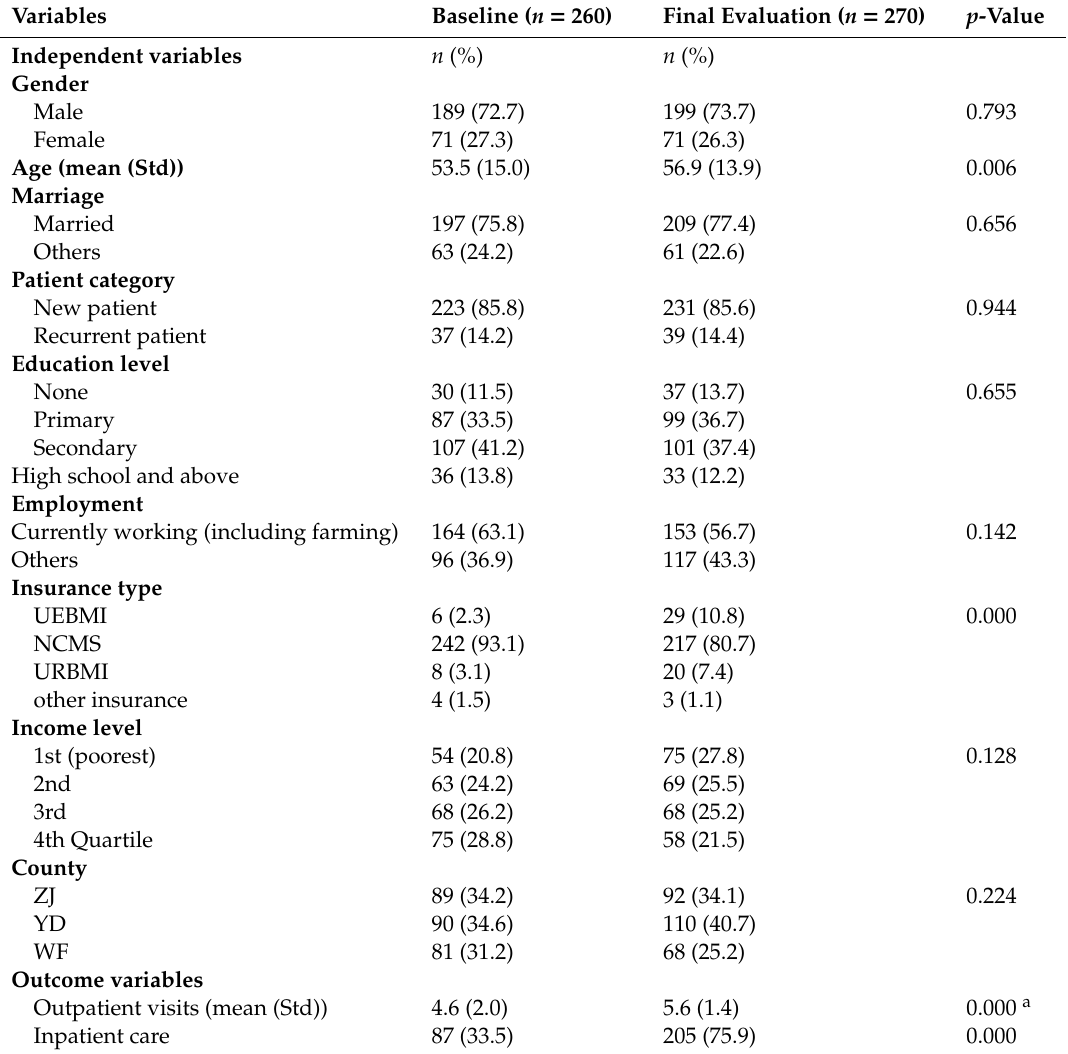
Table 1. Descriptive statistics of variables in the baseline and final